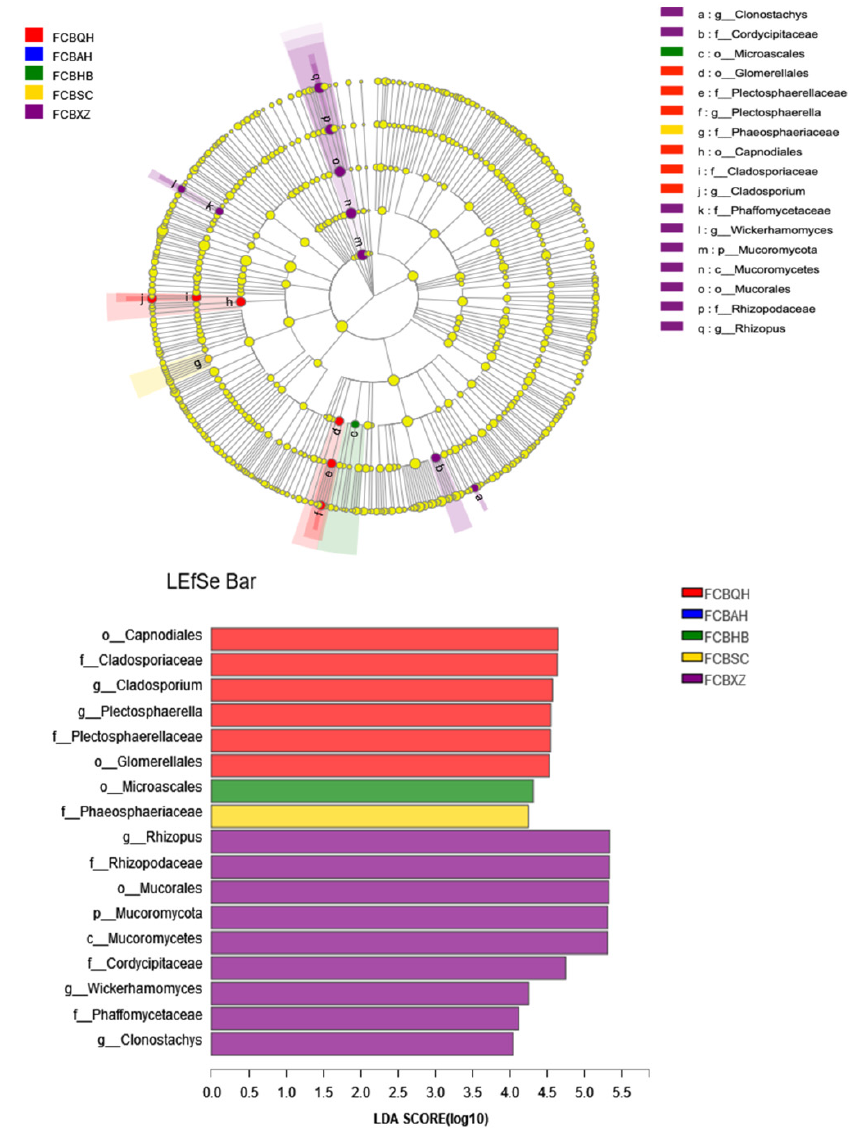
Figure 3. LEFSe analysis of differences in fungal community ranging from the genus level to the phylum level. Different color nodes denote the microbial groups significantly enriched in the corresponding groups and that had significant influence on the differences between groups.